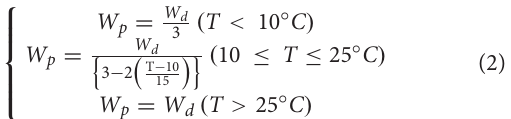
respectively. However, because the Secchi disk depth includes an attenuating effect of phytoplankton and the model domain is based on open ocean, we performed several sensitivity tests for evaluating a reasonable attenuation coefficient and selected 0.09 m − 1 as an adequate value in the